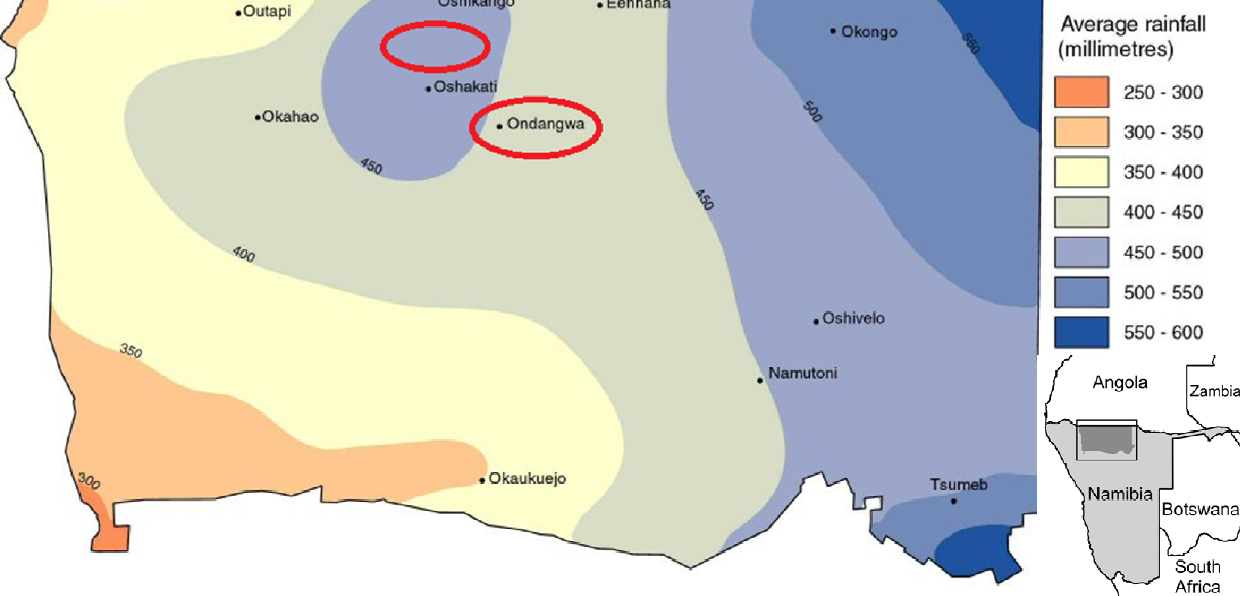
Figure 2. Map of central-northern Namibia with annual average rainfall [26] with marked project location and Ondangwa meteorological station and small map of Namibia